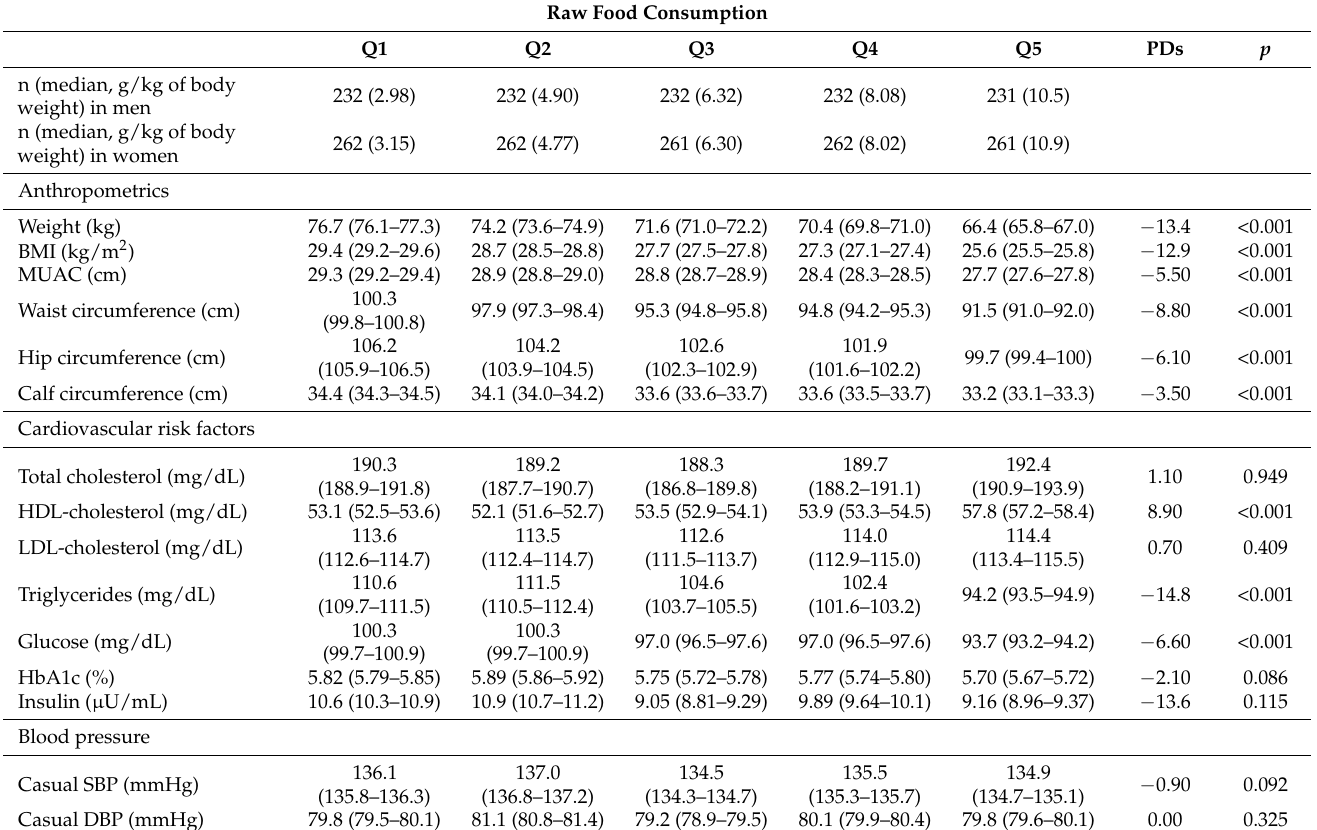
Table 2. Adjusted means (95% confidence interval), percentage difference, and p for a linear trend across quintiles of raw food